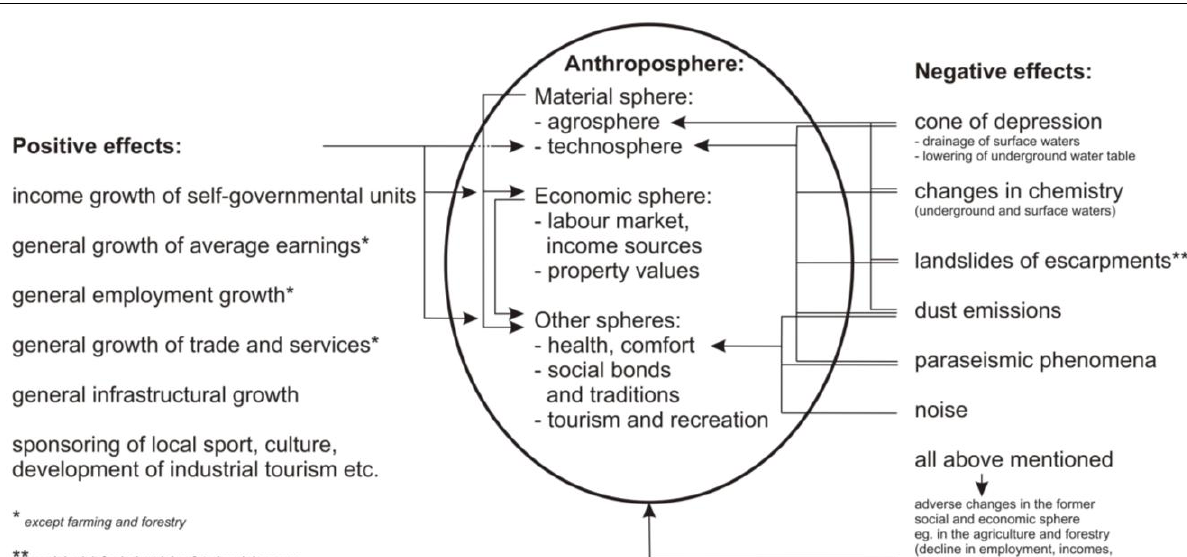
Fig. 1. Map of Polish lignite deposits against the background of the administrative division (only host provinces)